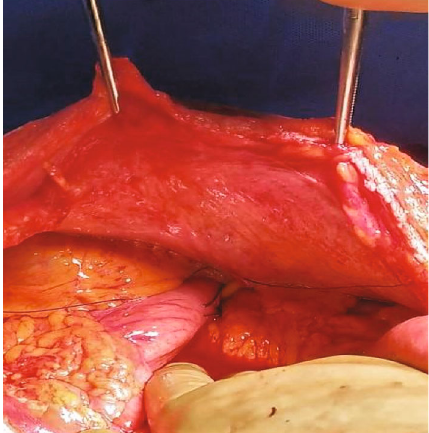
Figure 4: A gastropexy is performed with two single resorbable sutures, concealing the tube and anchoring the stomach to the parietal peritoneum of the left abdominal